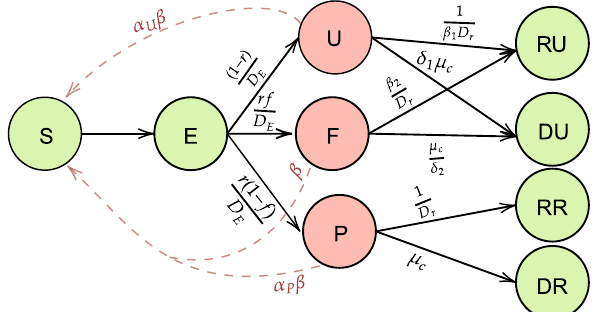
Figure 2. Diagram describing model compartments and transmissions for the extended SEIR model. For the detailed descriptions of the compartments and parameters, please refer to Supplementary Table 2 and the “Methods”